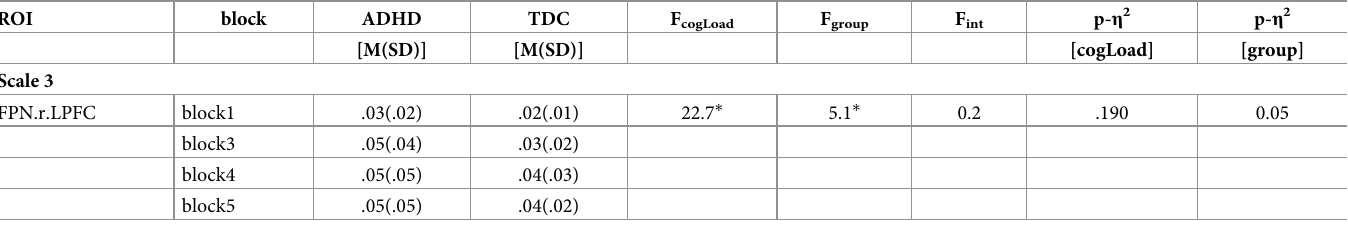
Table 2. Significant results of 2x4 repeated measures MANOVA models using cognitive load and group , and wVar.